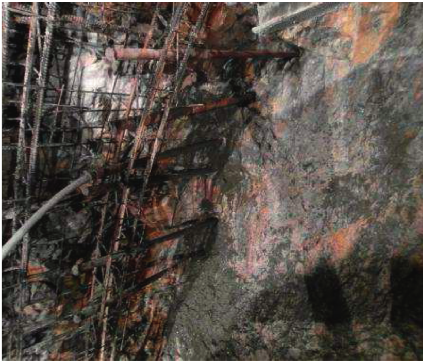
Figure 12: Treatment of karst cavern in the Hebai tunnel.